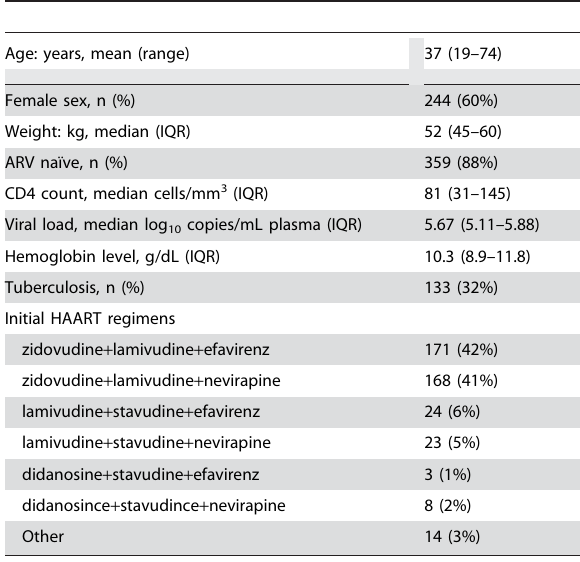
Table 1. Baseline characteristics of patients prior to initiating HAART in the IDCC, Gaborone, Botswana